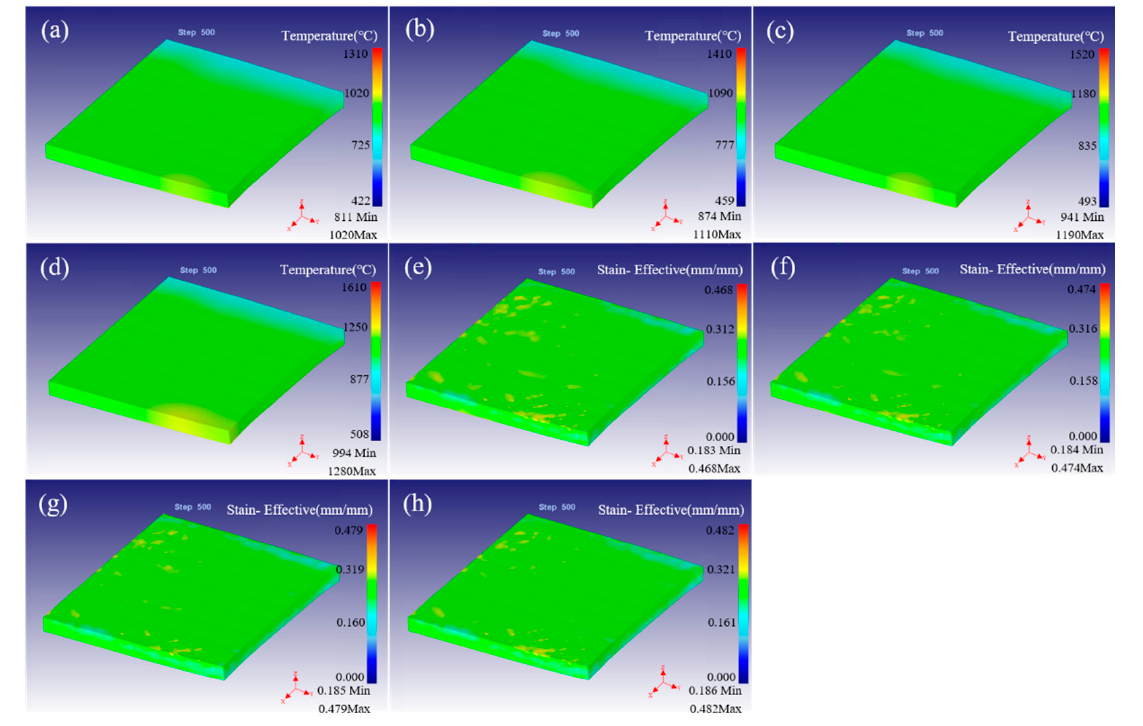
Figure 3. The distribution of temperature field ( a – d ), and strain field ( e – h ) by FEM simulation under different rolling temperatures of 1300–1600 °C.